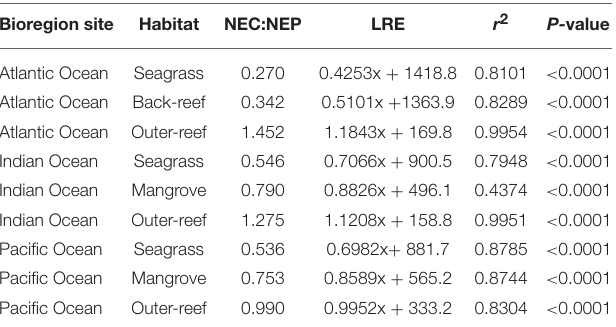
Ratios of net ecosystem calcification to net community production (NEC:NEP) were calculated from the slopes of best-fit linear regression with all sites showing a relationship between salinity-normalized total alkalinity (nA T ) and total carbon (nC T ), with p < 0.05, and 8 out of the 9 sites r 2 > 0.5. NEC:NEP was calculated using the expression 1/[(2/m)– 1], where m is the slope from the corresponding linear regression equations (LRE). Calcification and dissolution are dominant processes when a linear regression slope approaches